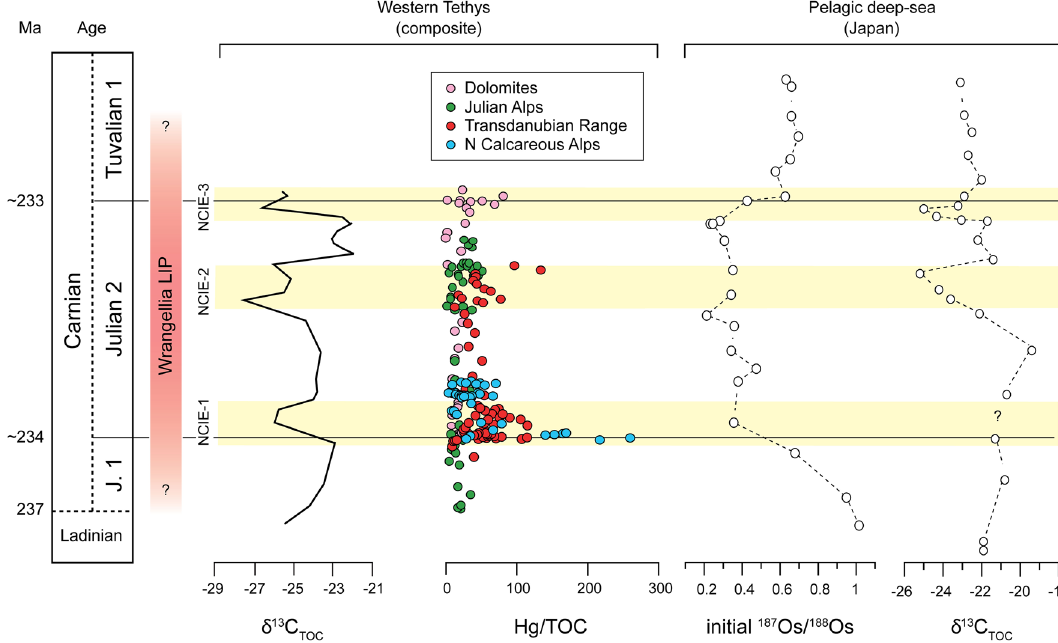
Figure 4. A comparison of our Western Tethys composite Hg/TOC stratigraphy with Os-isotopes through the same period associated with the Carnian Pluvial Episode recorded in Japan. Os and C-isotope data from Panthalassa are from ref. 16 . C-isotope data from the Western Tethys are from ref. 8 . The approximate period of the Wrangellia LIP emplacement is taken from refs. 6,8,9,14,16,25,48